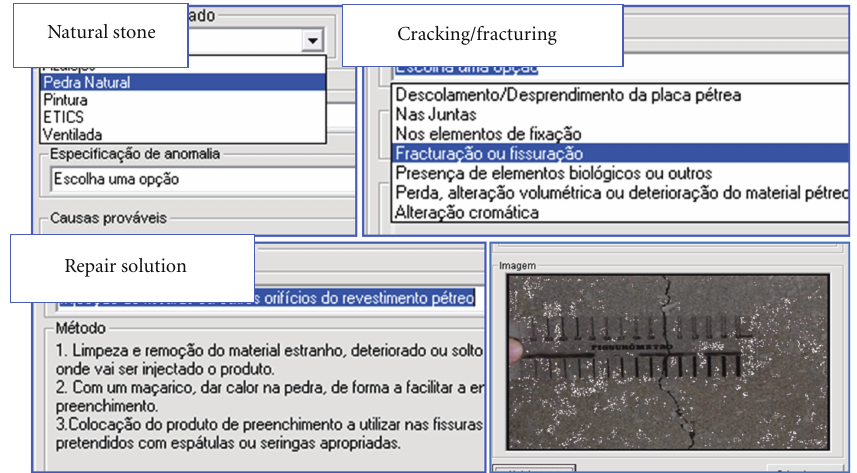
Figure 12: Selecting data in the inspection